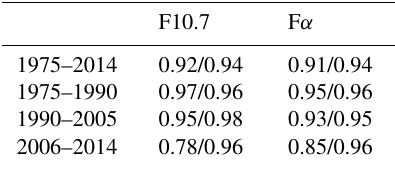
Table 3. Percentage of total variance of yearly values of fo E ac- Table 5. Percentage of total variance of yearly values of fo F2 ac- counted for by solar activity proxies and trend (Eq. 2) for the whole counted for by F10.7 (Eq. 1) for the whole period and for three period and for three sub-periods, for Juliusruh and Chilton (values sub-periods for Chilton. separated with a slash). F10.7